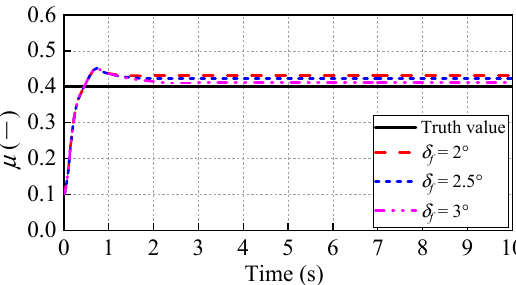
Figure 8. RFC estimated by traditional MHE.